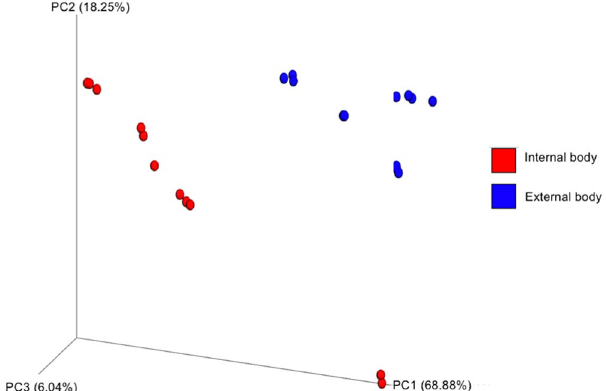
Figure 3. Principal coordinate analysis of bacterial composition between internal (endogenous) and external body (exogenous) samples of adult black blow flies. Analysis was based on the weighted Unifrac metric.